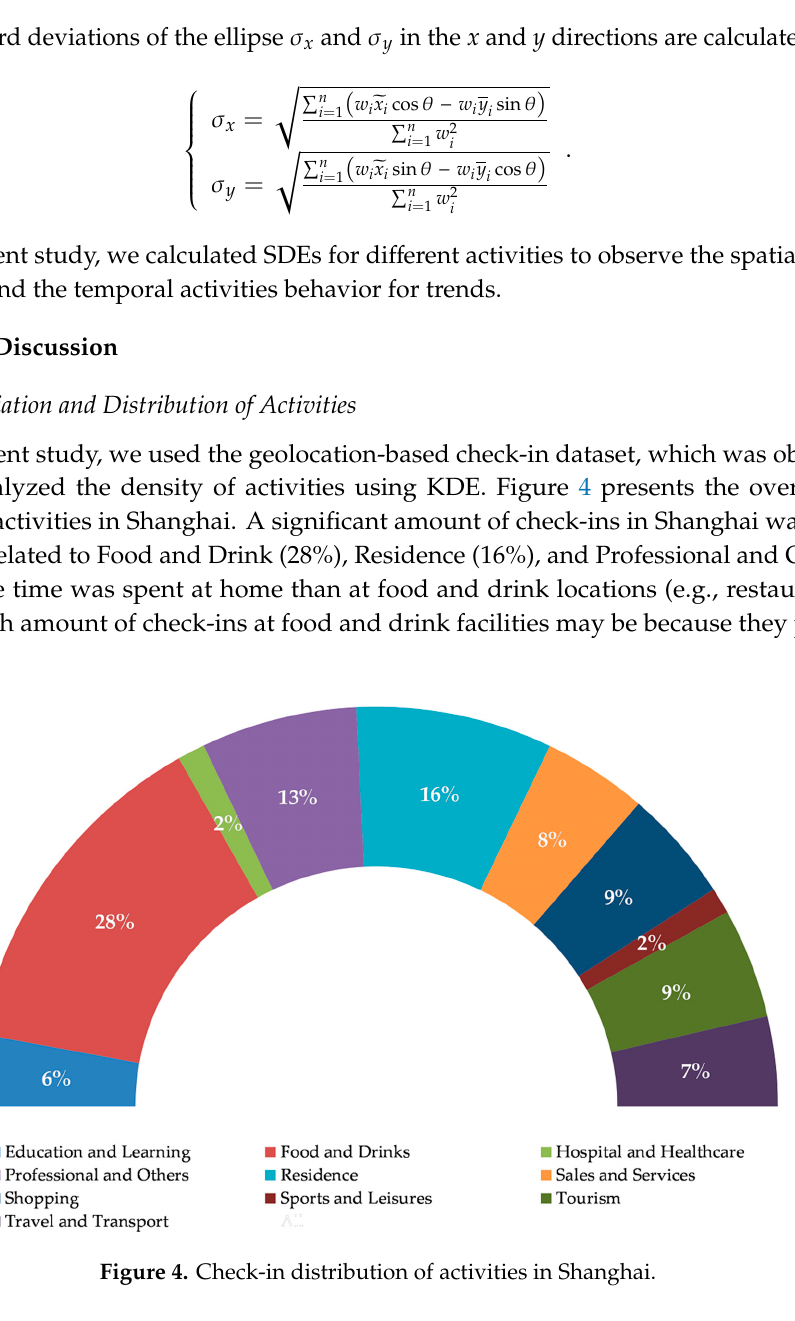
Figure 5. Sex-based distribution of activities during weekdays and weekend. Figure 6 presents the kernel densities of activities in Shanghai. The check-in densities for Education and Learning, Hospital, Healthcare, and Sports and Leisure were relatively low and dispersed over the study area.